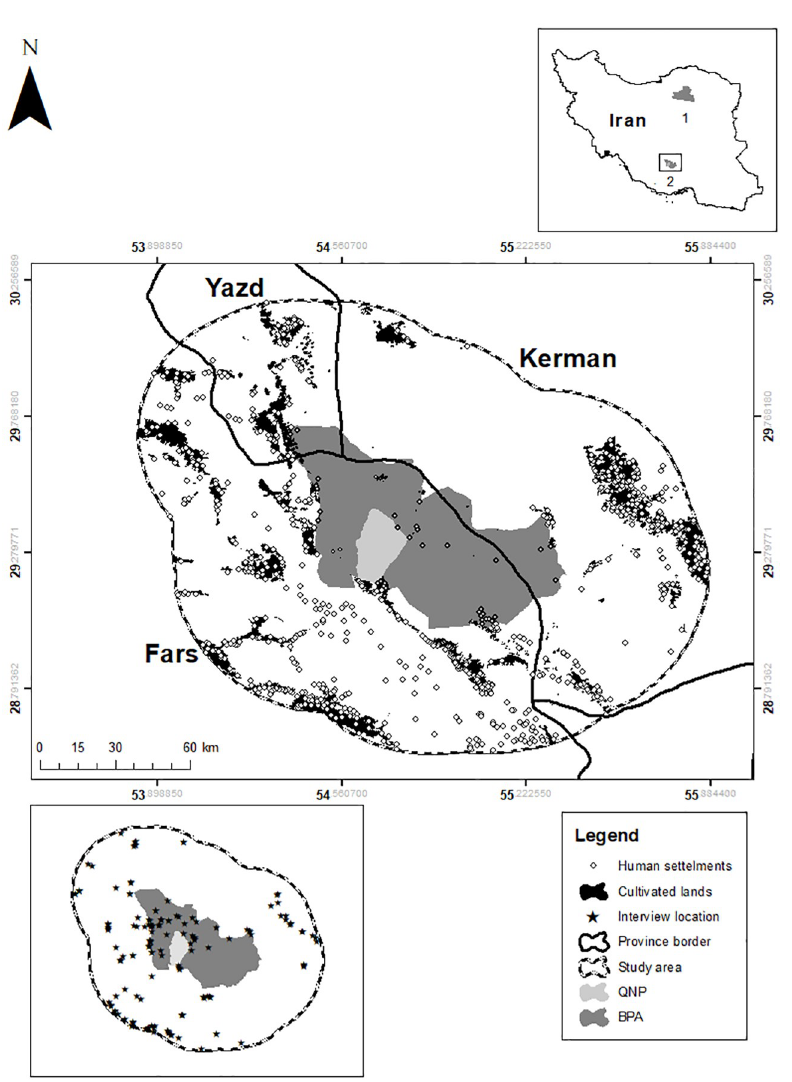
Fig 2. Current wild distribution of onager in Iran. (1) Touran Biosphere Reserve and (2) Bahram-e-Goor Protected Area (BPA) surrounding Qatrouiyeh National Park (QNP). Study area and location of interviews with local communities in BPA and a 50-kilometer surrounding